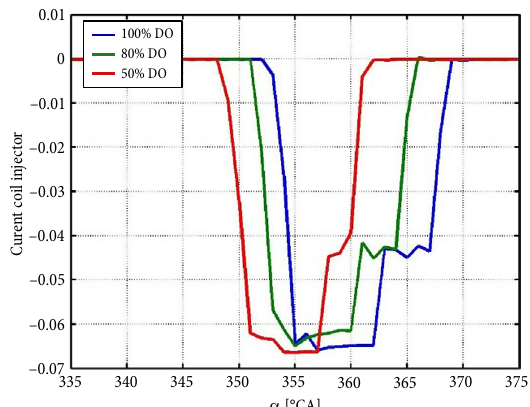
Fig. 9. Injector control current versus CA; n = 3400 rpm; T = 100 Nm (different doses of diesel oil)